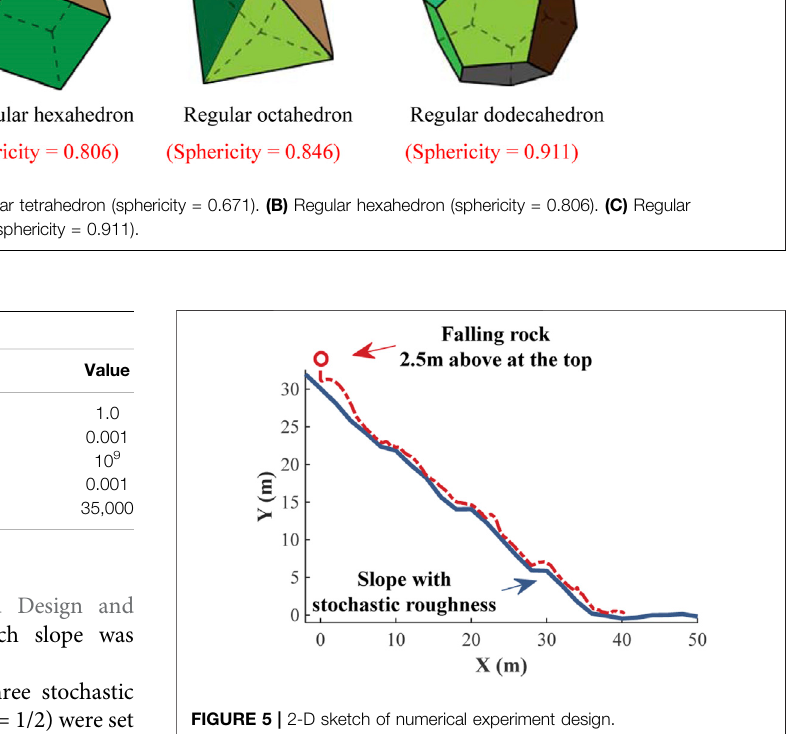
FIGURE 5 | 2-D sketch of numerical experiment